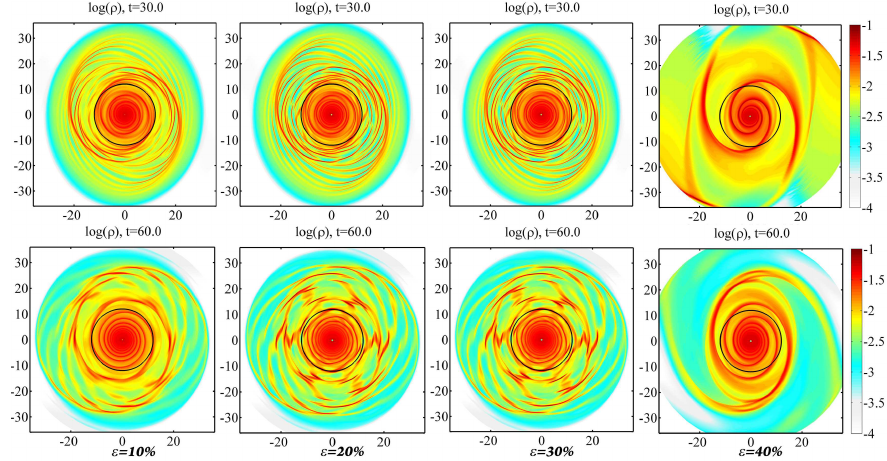
Fig. 4. Same as in Fig. 3, but for the model with Q T = 1 . 8 and various values of ε